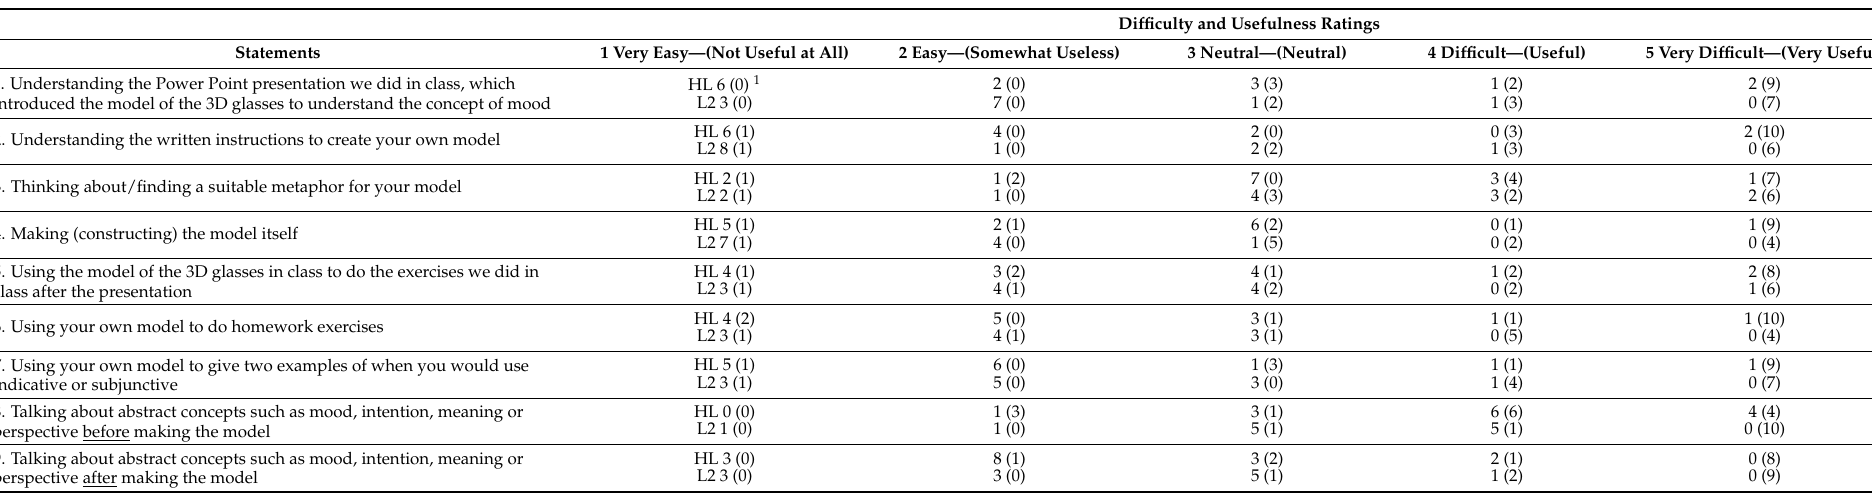
Table 4. Results of the feedback questionnaire administered after MCE